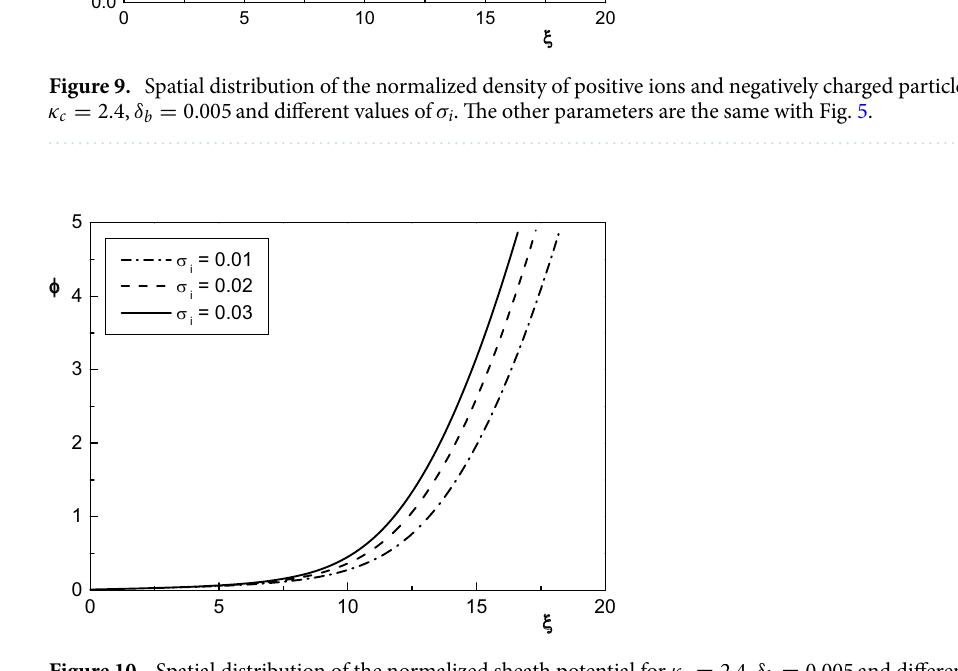
Figure 10. Spatial distribution of the normalized sheath potential for κ c = 2.4 , δ b = 0.005 and different values of σ i . The other parameters are the same with Fig.